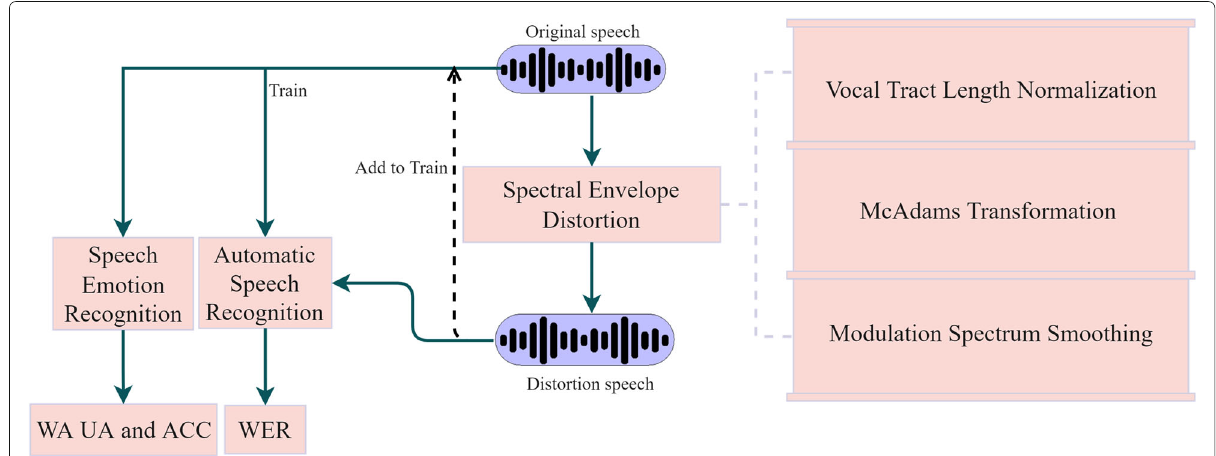
Fig. 1 Adversarial attacks against speech emotion models flow chart